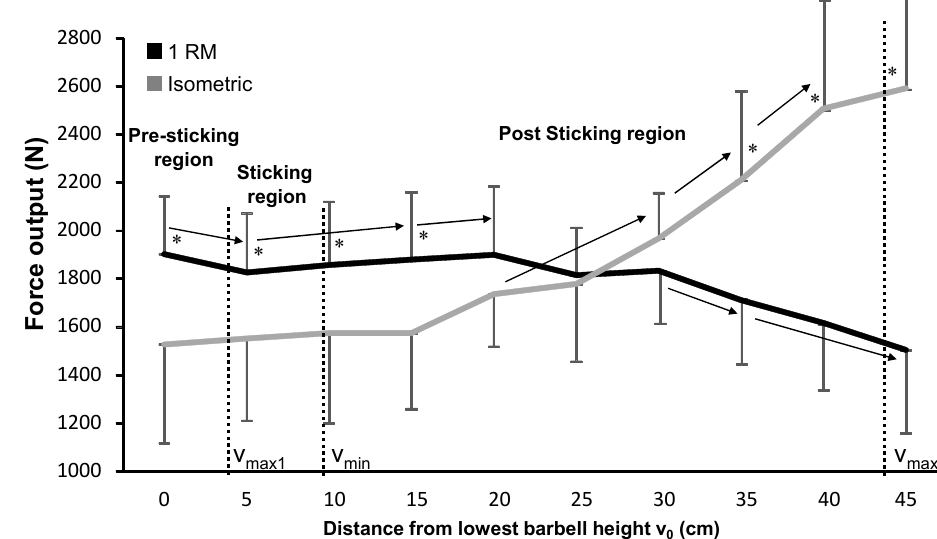
Figure 2. Mean ( ± standard deviation) maximal force output at the different vertical distances from the lowest barbell position for the one-repetition maximum (1-RM) squat attempt and the isometric contractions. * Indicates a significant difference ( p < 0.05) in force output between the 1-RM and isometric attempts at this distance. → Indicates a significant difference ( p < 0.05) in force output between these two distances for this condition.